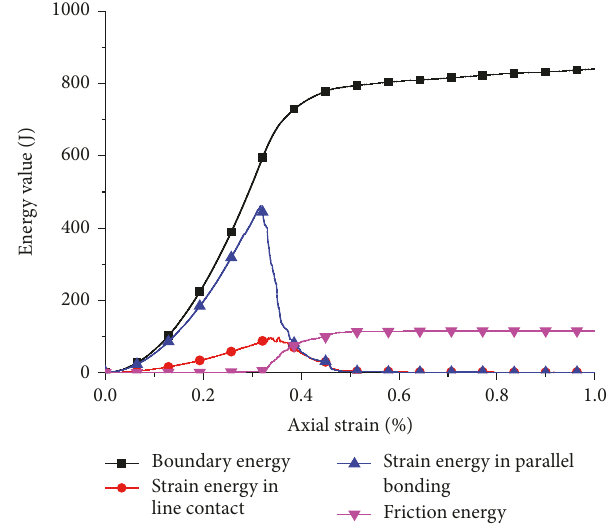
Figure 17: Curves of energy conversion during compression.